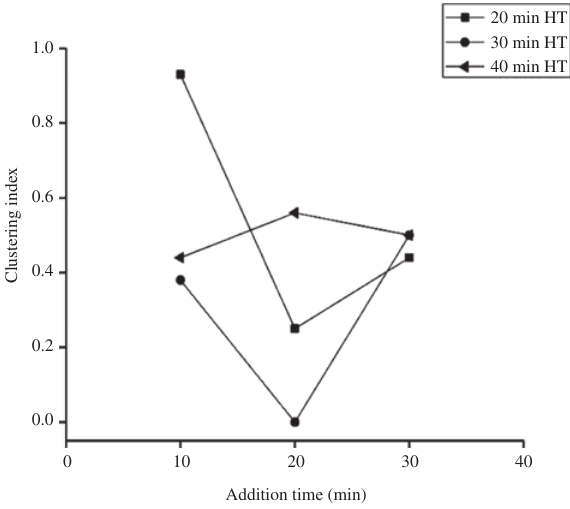
Figure 5: Variation of clustering index with respect to constant AT.